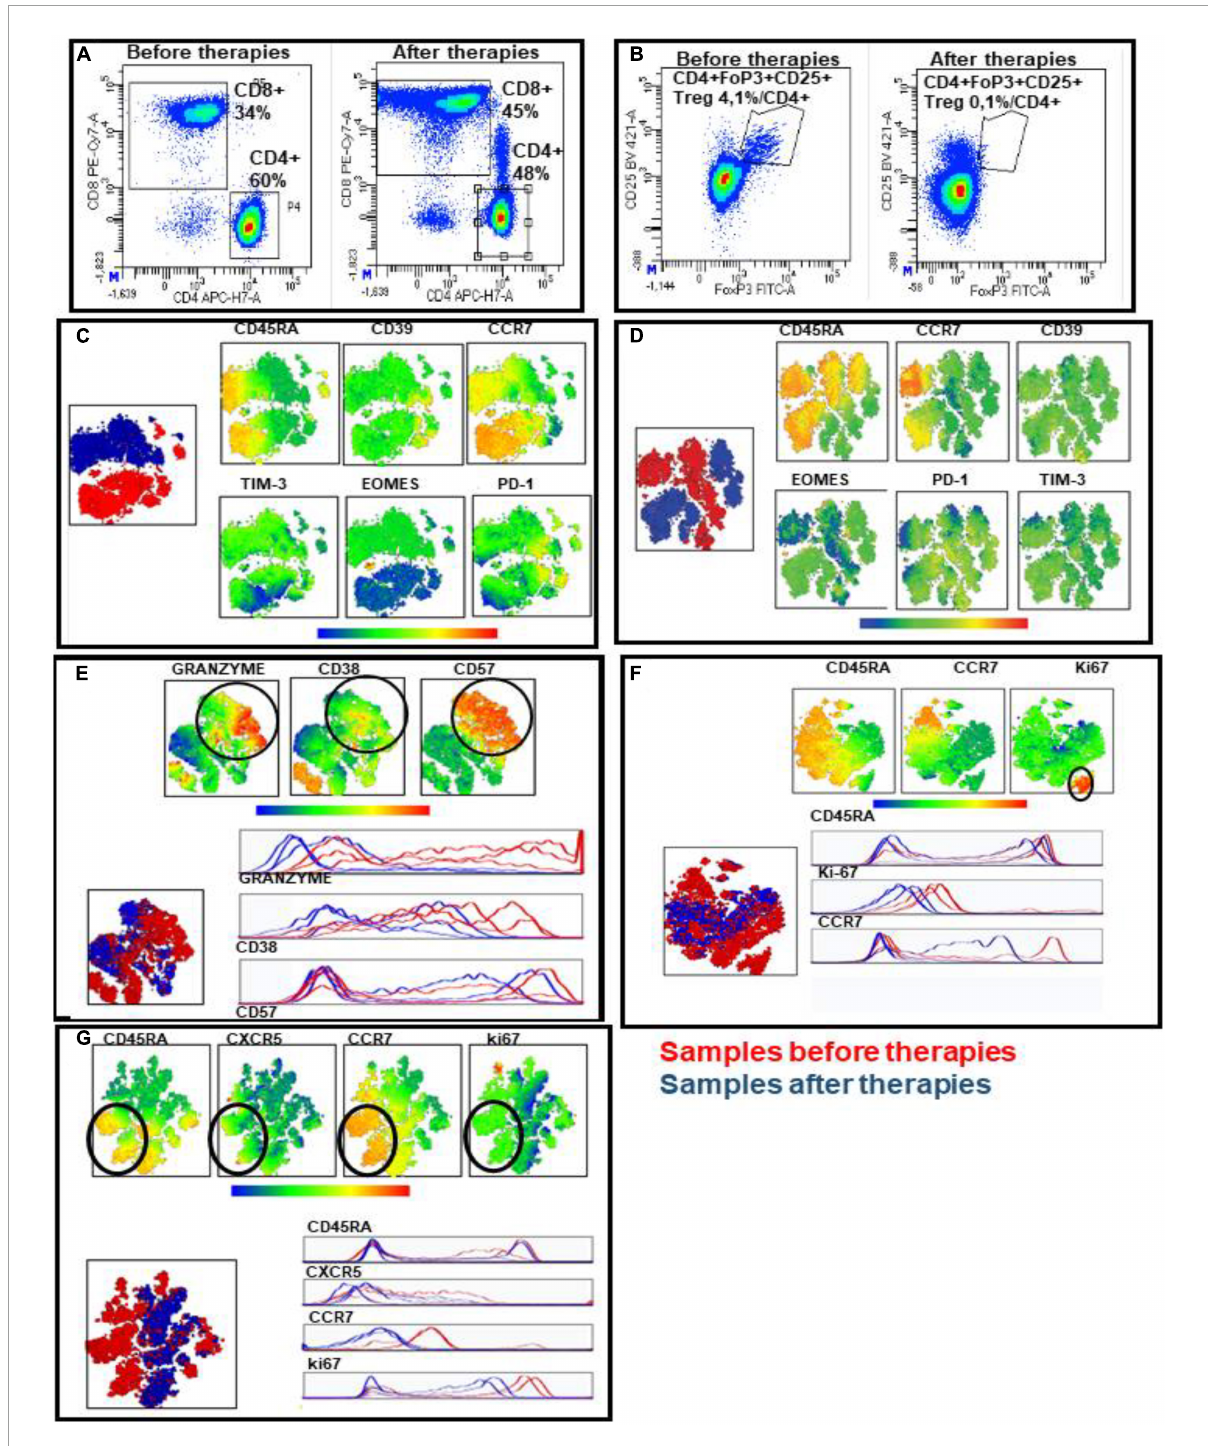
FIGURE3 Immunofluorescence analyses of two patients with RT-PCR SARS-CoV-2 positive viremia and bronchoalveolar lavage fluid. (A,B) Representative examples of CD4+ and CD8+ T subset percentages on peripheral CD3+ T cells derived from before and after therapies (A) and frequency of circulating CD4+ Treg (CD4 + FoxP3 + CD25 +) on circulating CD4+ T population derived from before and after therapies (B) . (C–G) Multidimensional data reduction analysis. t-SNE analysis of maturation, senescence, exhaustion, effector and activation markers of circulating CD4+ and CD8+ T cells on merged samples derived before (red clusters) and after (bleu clusters) therapies. In particular: the analysis of maturation and exhaustion marker expression in CD4+ (C) and CD8+ (D) T subsets; the analysis of maturation, senescence and granzyme effector molecule in CD8+ T cells (E) ; the evaluation of cycling cells by ki-67 marker in CD8+ (F) and CD4+ (G) T